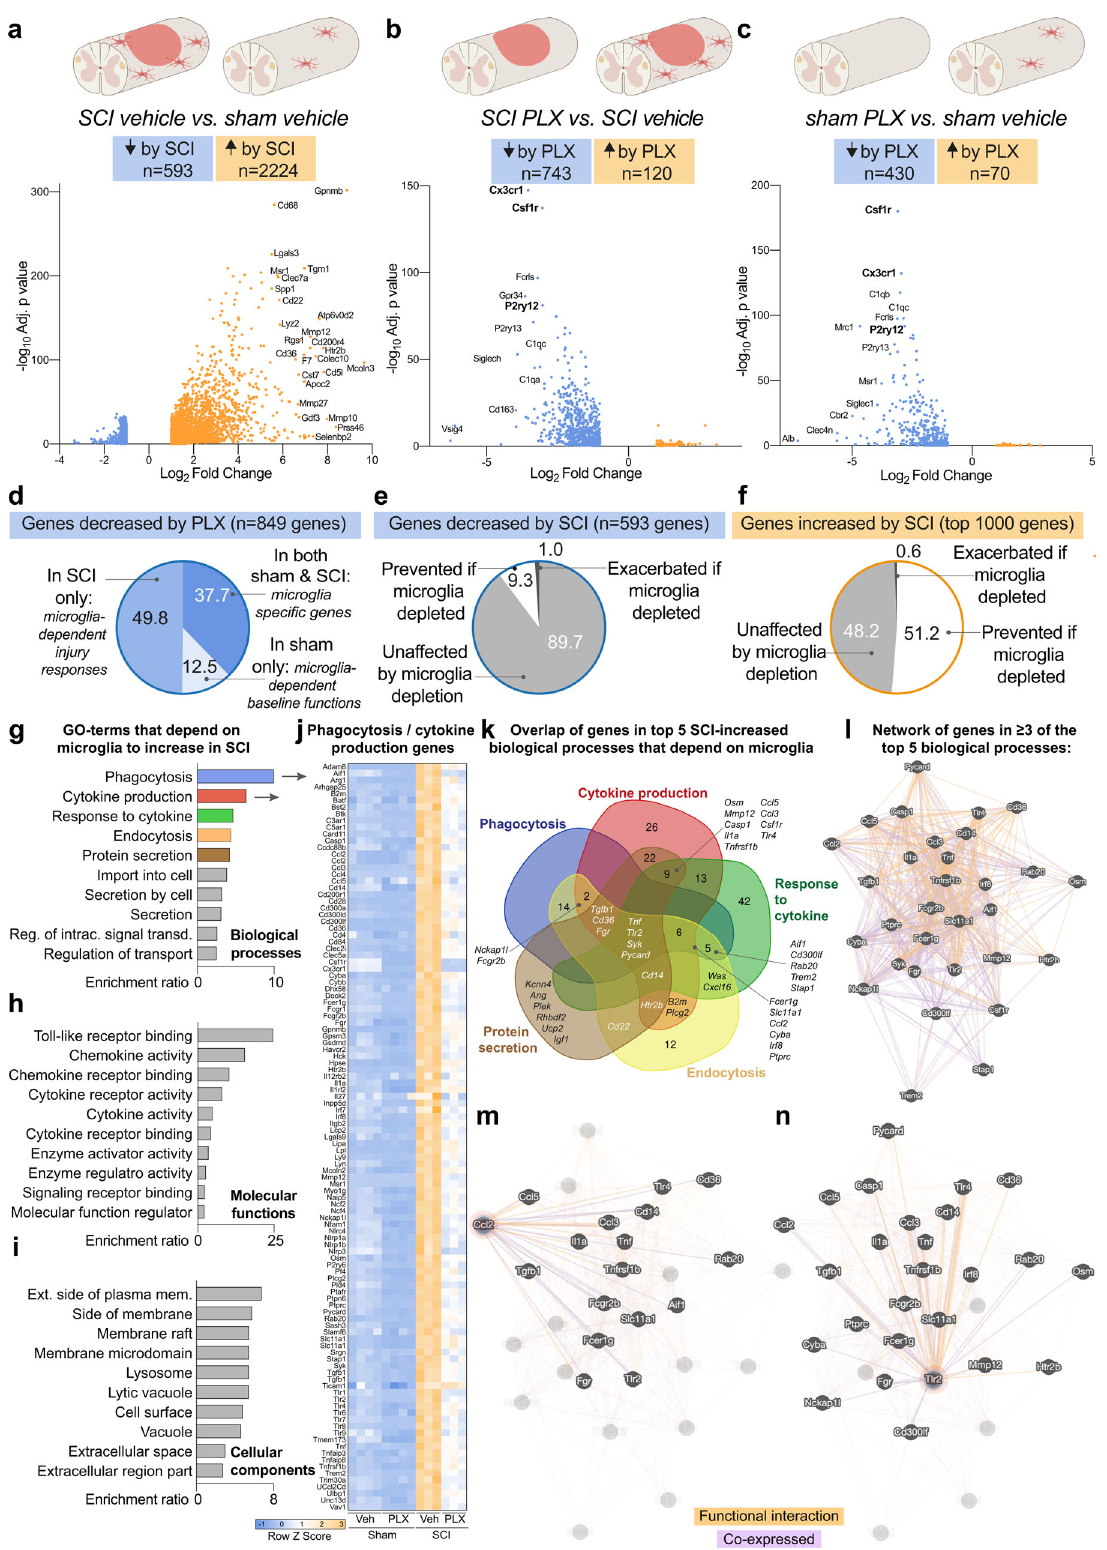
Functional heterogeneity of microglia in injured spinal cord revealed by scRNA-seq . Data in Fig. 1 and Sup. Fig. 5 indicates that after SCI, microglia become activated and coordinate intercellular communication to promote tissue repair. To